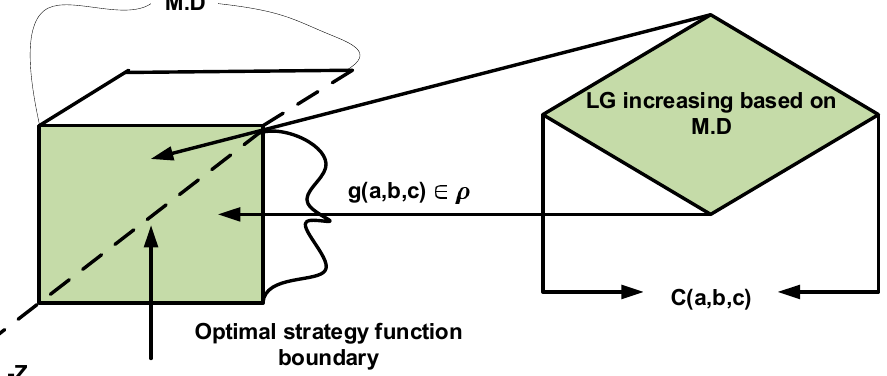
Figure 8. Cost function reduction using local gain for optimal strategy.